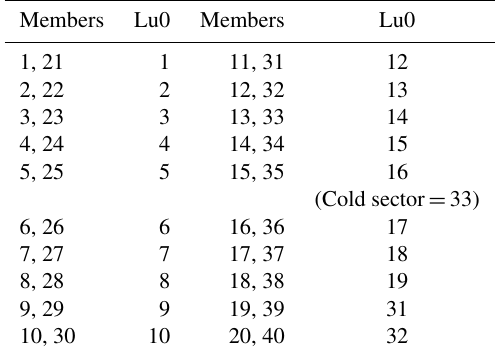
Table 1. The surface types used to generate the initial ensemble of forecasts. Lu0 is the initial land use index in the CM1